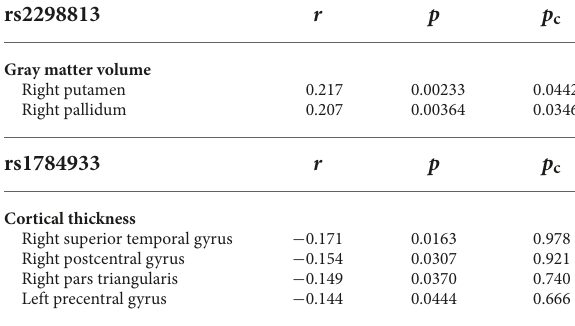
TABLE 3 Associations of homozygous major allele carriers of rs2298813 and rs1784933 with regional cortical thickness/gray matter volume in other brain